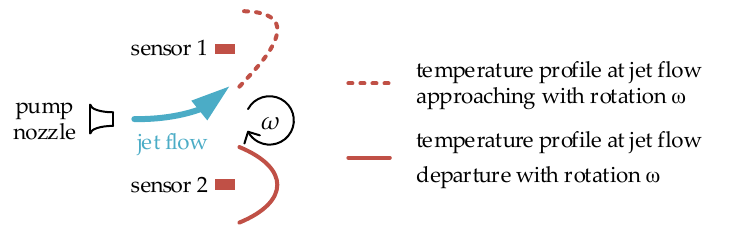
Figure 2. The schematic of jet flow gyroscope.